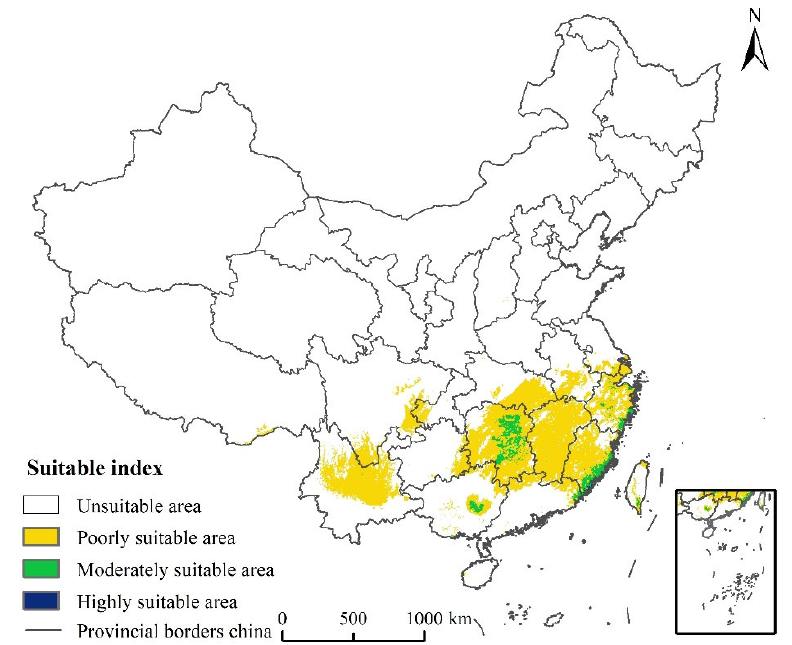
Figure 6. Potential suitable area for Linepithema humile under current climatic scenarios in China .